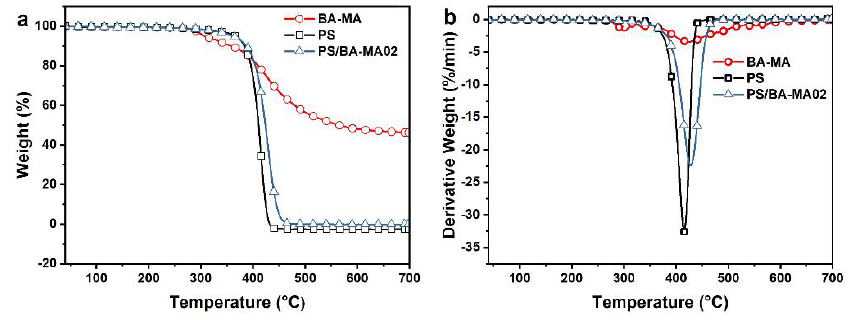
Figure 5. TG ( a ) and DTG ( b ) curves for PS, BA-MA, and PS/BA-MA.